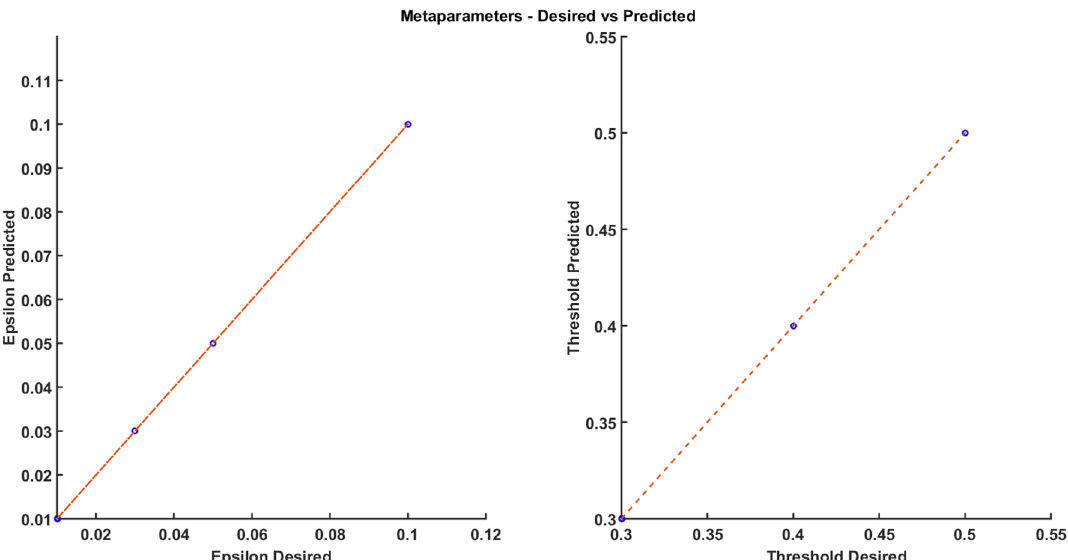
Figure 4. ( A ) The parameter fit is checked for the predicted vs. desired meta parameter ( ǫ ). ( B ) The parameter fit is checked for the predicted vs. desired meta parameter (V TH